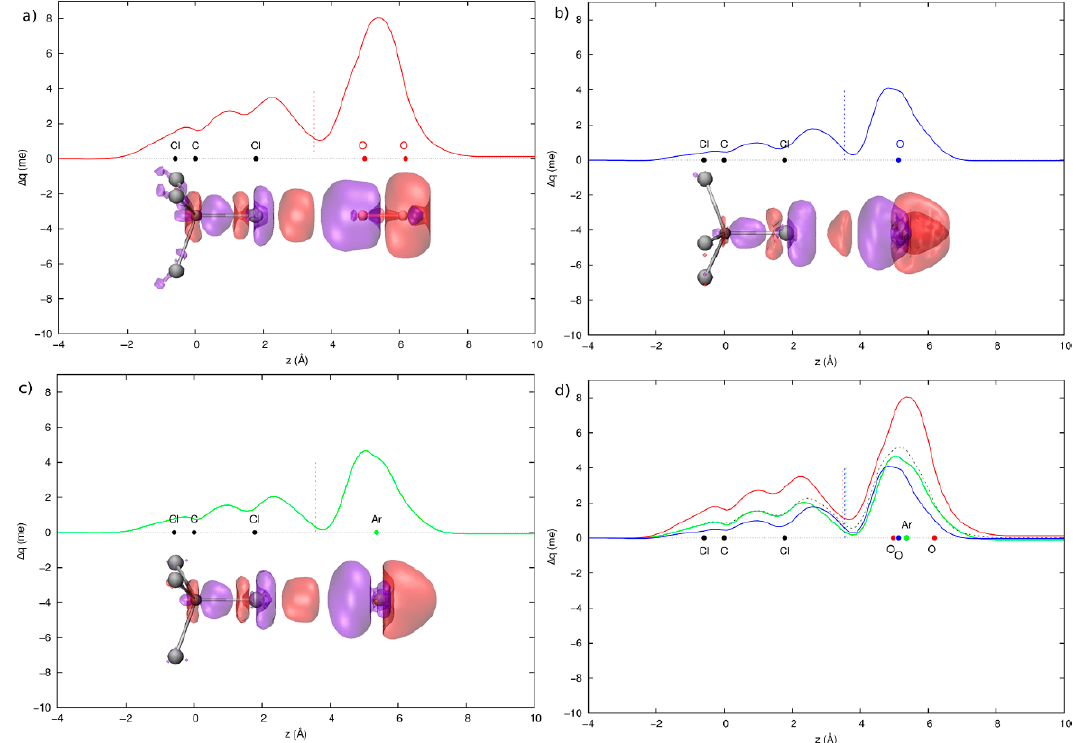
Figure 3. Charge displacement (CD) curves for the vertex configuration of the O 2 -CCl 4 system in the collinear ( a ) and perpendicular ( b ) orientations of the O-O bond and for the Ar-CCl 4 system ( c ). ( d ) CD curves for the O 2 -CCl 4 system in the collinear (red) and perpendicular (blue) orientations and that obtained as weighted average in the ratio 1:2 (curve with dashed line), according to their degeneracy, are compared with the CD curve of the Ar-CCl 4 system. The insets show the 3D isodensity plots of the electronic charge due to the intermolecular interaction (cuto ff = ± 0.05 me / bohr 3 , with negative / positive values in red / blue). (from Reference 56, Copyright © 2020, American Chemical Society, with